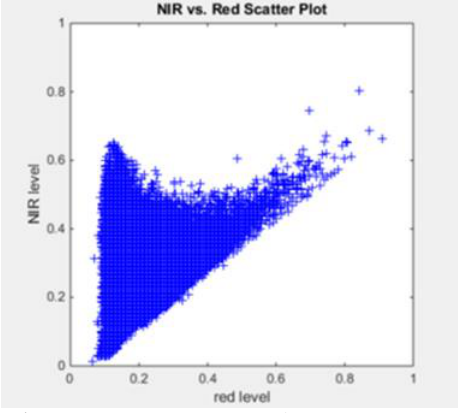
Figure 11. Histogram graph of the analyzed land. The NDVI calculation is performed using the NIR and Red values obtained in the next step.